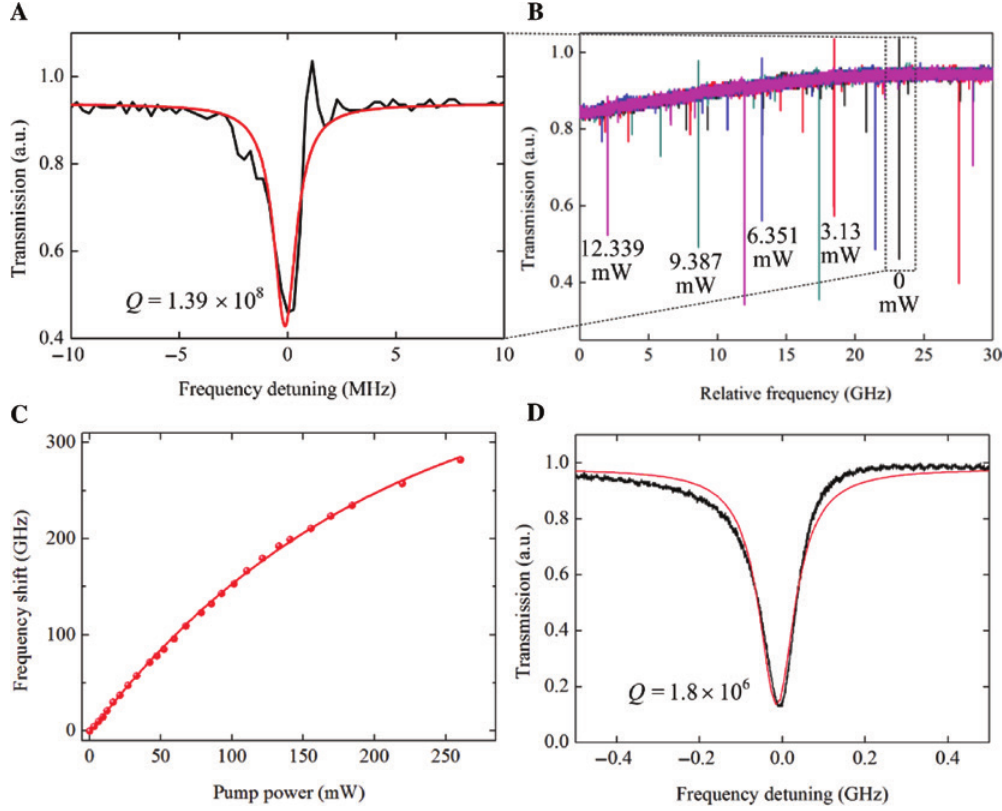
Figure 4: Optical performance and tunability of the fabricated microbottle cavity. (A) Transmission spectrum of a single resonance mode of the higher- Q microbottle cavity. The red line is corresponding Lorentzian fitting. (B) 30-GHz range transmission spectra of the higher- Q microbottle cavity with different pump powers. (C) Resonant frequency shift versus the pump power, with the measured data in the red dot and the fitted data in the red line. (D) Transmission spectrum of a single resonance mode of the lower- Q microbottle cavity. The red line is corresponding Lorentzian